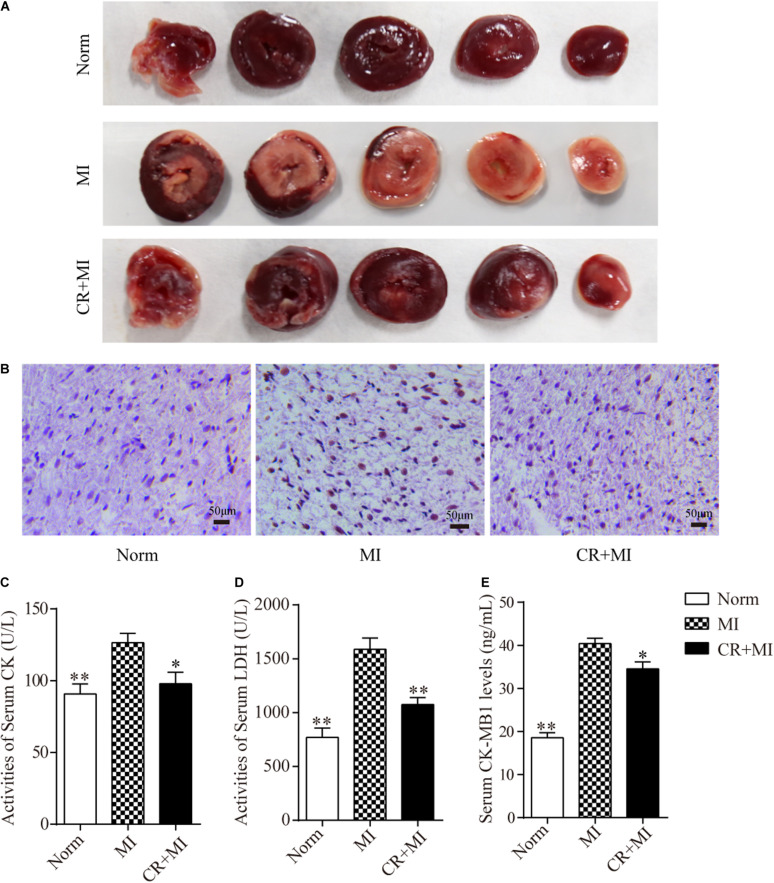
Effects of CR pretreatment on myocardial ischemic injury. (A) Representative morphological images of myocardial tissue in norm, MI, and CR + MI groups after TTC staining. (B) TUNEL assay of myocardial tissues in norm, MI, and CR + MI groups. Brown staining of the nucleus indicates apoptosis. (C) The activities of serum CK were determined by CK assay kit in norm, MI, and CR + MI groups. (D) The activities of serum LDH were examined by LDH activity detection kit in norm, MI, and CR + MI groups. (E) The levels of serum CK-MB1 were measured by CK-MB1 ELISA kit in norm, MI, and CR + MI groups. The data are presented as the mean ± SEM (n = 6). *P < 0.05, **P < 0.01 compared with the MI group.